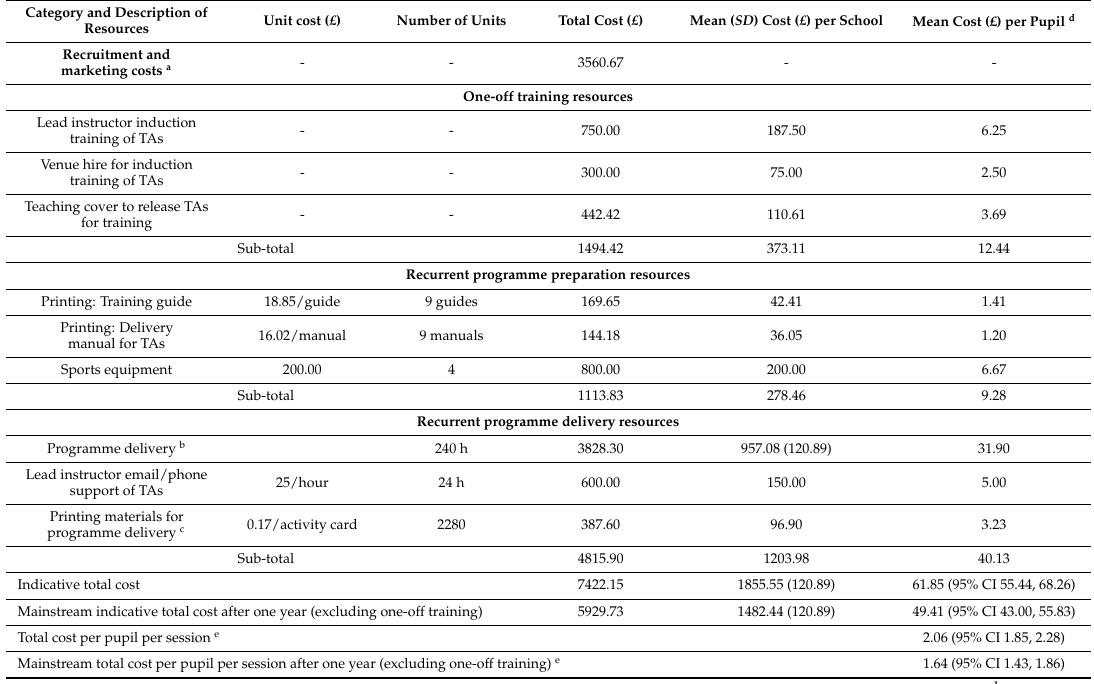
Table 4. Action 3:30 costs and